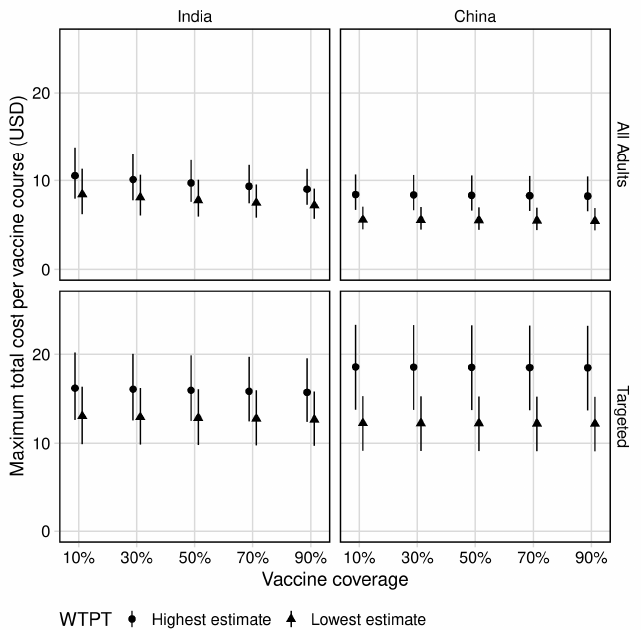
Figure 2. Maximum total cost per vaccine course. Top panels represent all-age vaccination (adults ≥ 10 years); bottom panels represent targeted vaccination (ages 50–59 in India and ages 60–69 in China). WTPT = country-specific willingness to pay thresholds per Ochalek et al. [9], estimated at $264 and $363 per DALY averted in India (lowest and highest estimates, respectively) and $3650 and $5669 per DALY averted in China (lowest and highest estimates, respectively). Costs discounted to 2018 values.